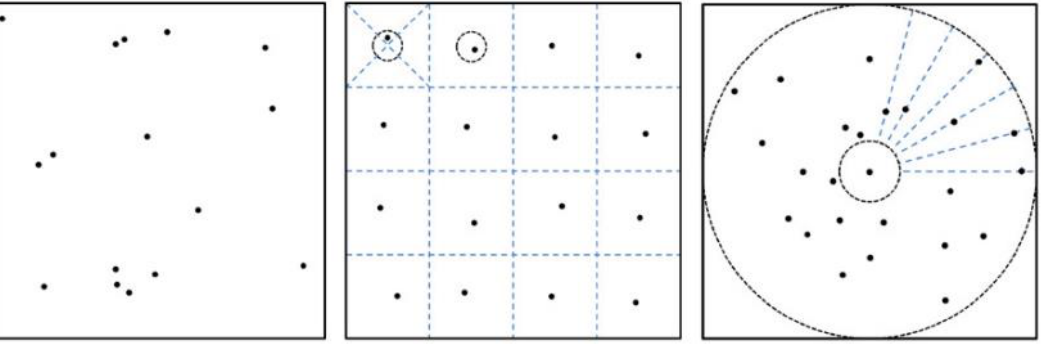
Figure 2. Examples of locations in random ( left ), grid ( middle ) and radial ( right ) distributions [8].